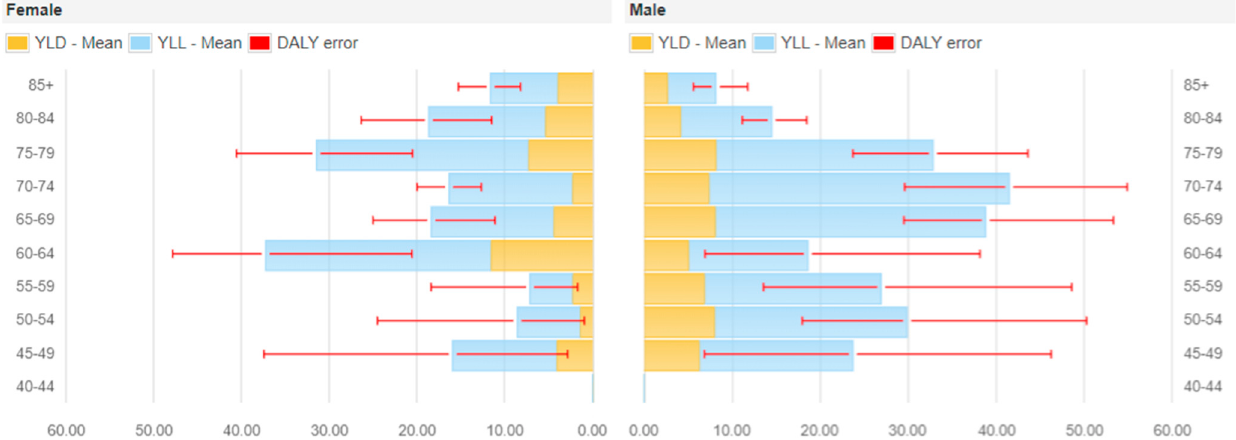
Figure 1. Estimated annual burden of selected HAIs on DALYs per 100,000 inhabitants aged 45 years and older (median and 95% uncertainty interval) by gender and age group, split between YLLs and YLDs.